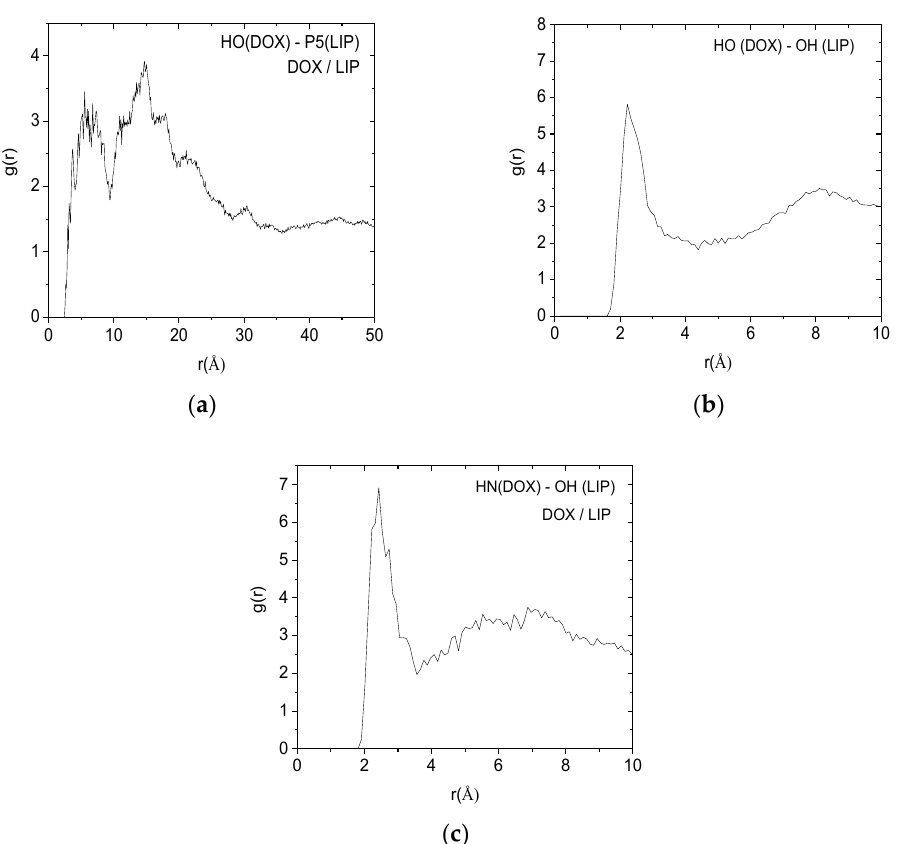
Figure 10. Pair correlation functions among atoms belonging to the neutral drug molecules (DOX) and the DPPG lipids (LIP). ( a ) Pairs between amine hydrogens of DOX (HN) and hydroxyl oxygens of the lipid (OH). ( b ) Pairs between hydroxyl hydrogens (HO) of DOX and hydroxyl oxygens (OH) of the lipid. ( c ) Pairs between amine hydrogens of DOX (HN) and phosphorus (P5) of the lipid. Table 4. Average number of hydrogen bonds per timestep for the examined pairs.